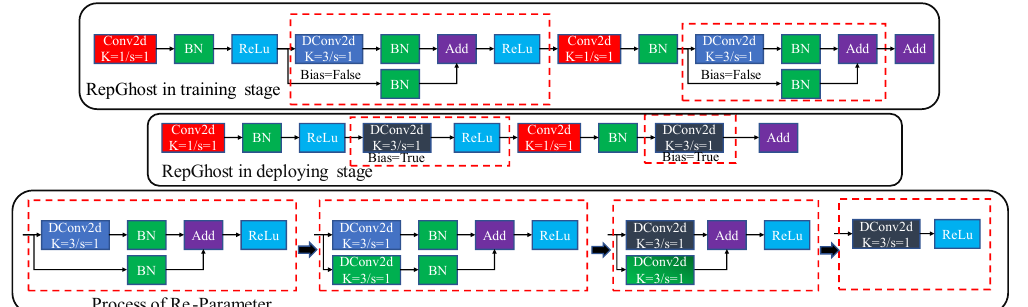
Figure 4. The structure of RepGhost and the process of re-parameter. During the training stage, there are BN branches. During deploying stage, there are only the convolution layer and activation layer. The process of the re-parameter is generating an equivalent convolution layer on the BN branch, fusing the convolution layer and BN layer, and fusing convolution layers on the two